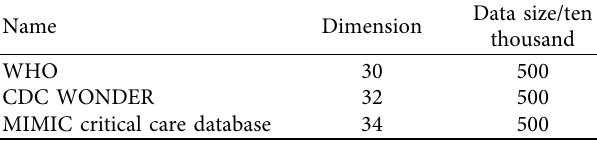
Table 1: Description of the experimental data set.